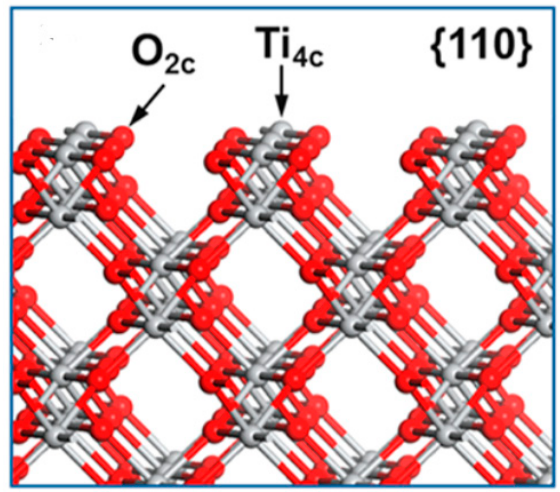
Figure 11. Surface atomic structures of the {110} crystal facet [10]. Reprinted with permission from ref. [10].